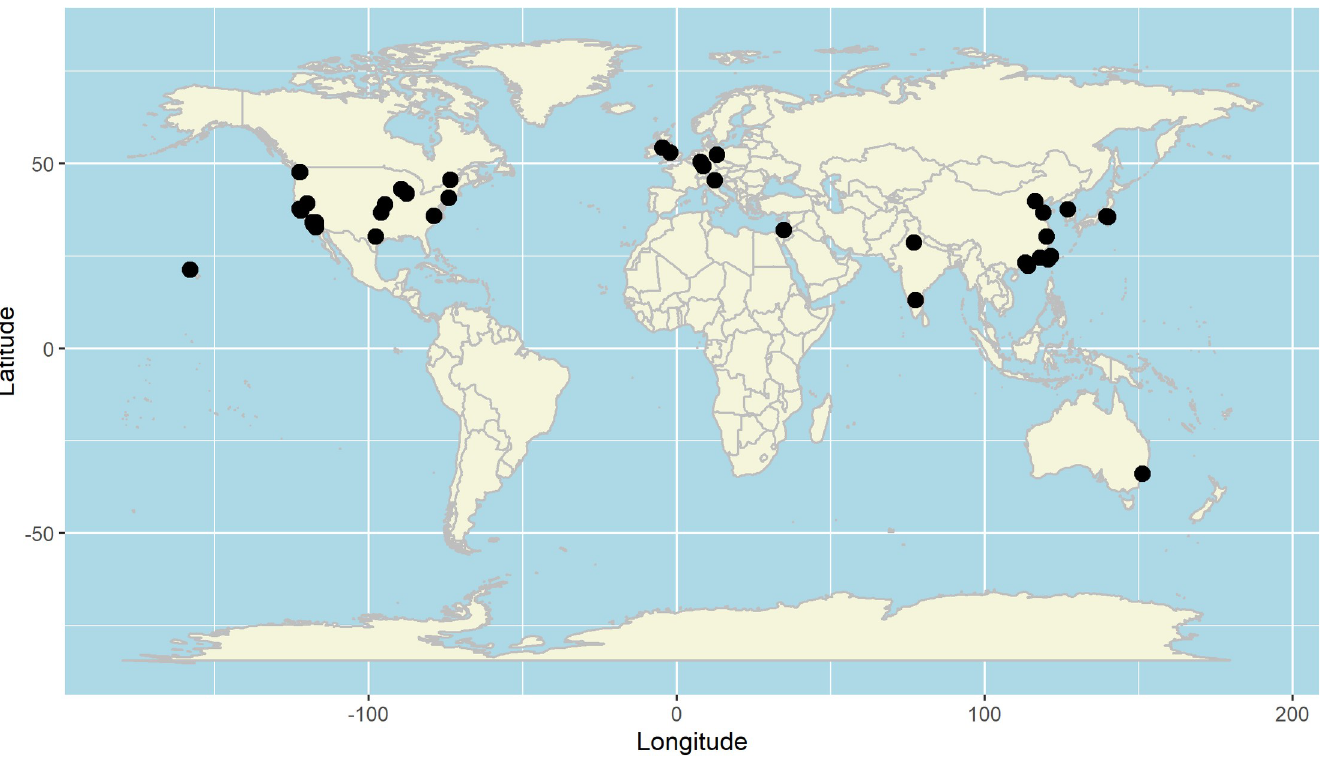
Fig 1. Global clusters of tech